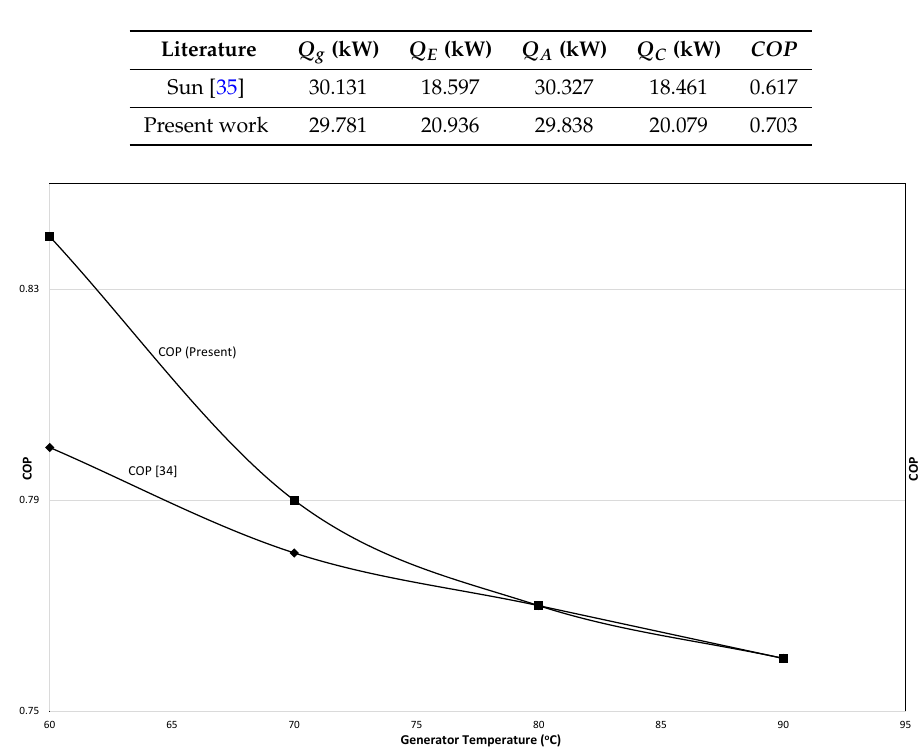
Table 8. Comparison of the energy flows and COP ( T E = − 5 ◦ C, T C = 40 ◦ C, T A = 30 ◦ C and T G = 100 ◦ C) [33,35].